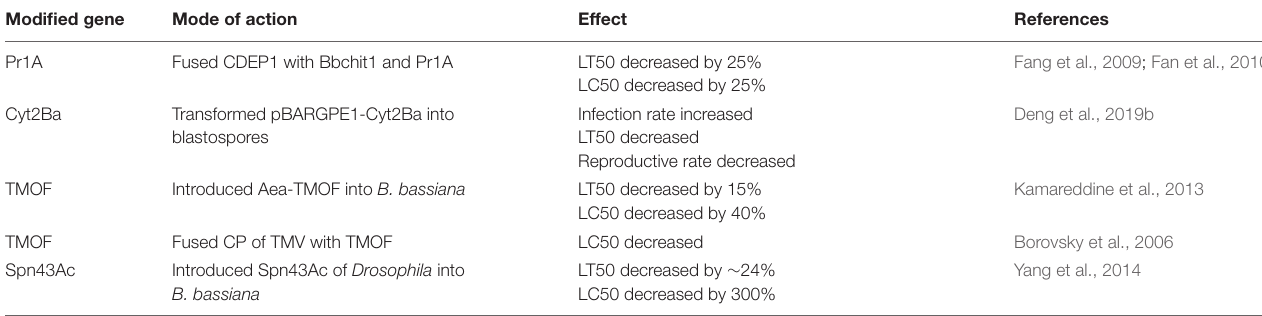
TABLE 2 | Target genes that improve virulence by genetic engineering